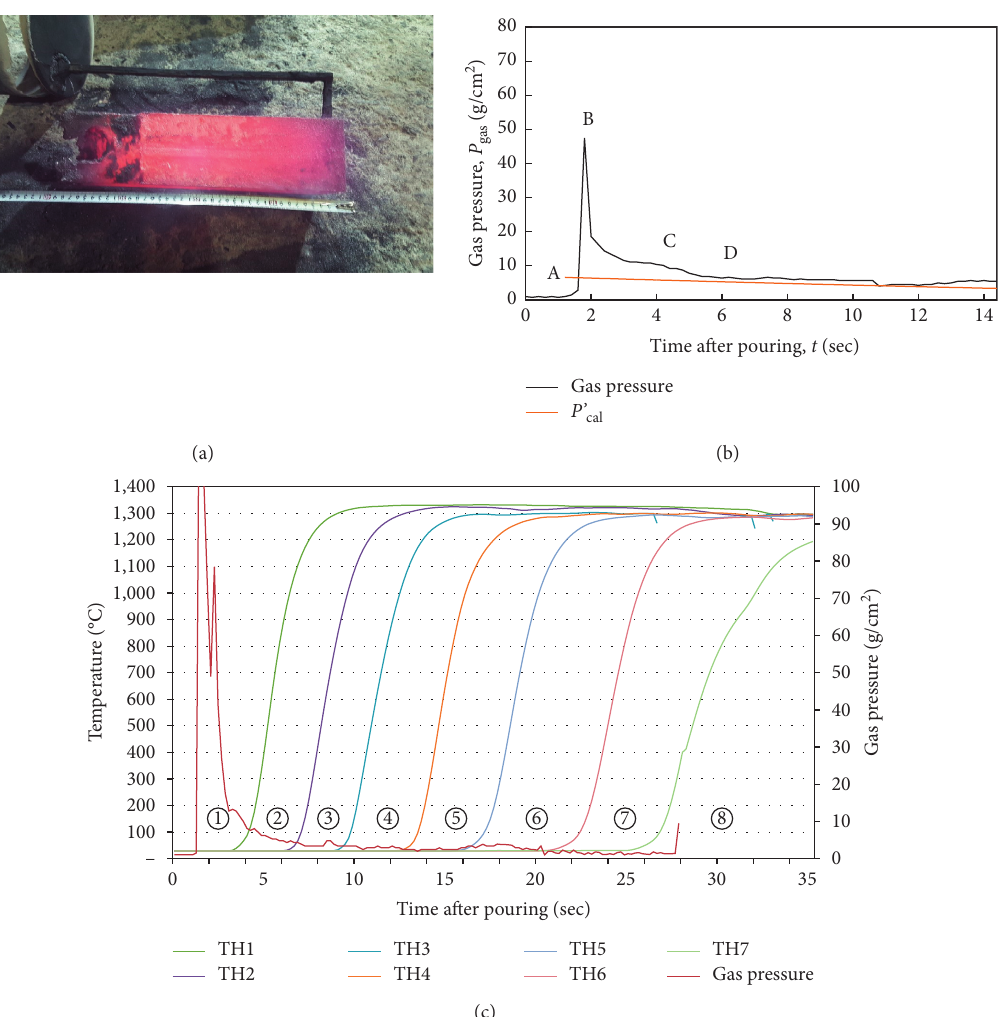
Figure 7: Gas pressure at the kinetic zone and temperature in the cast specimen during mold filling. The eight numbers in circles indicate the section between the thermocouple; (a) casting after the actual casting experiment; (b) gas pressure in the kinetic zone; and (c) gas pressure and temperature in the cast specimen during the actual casting